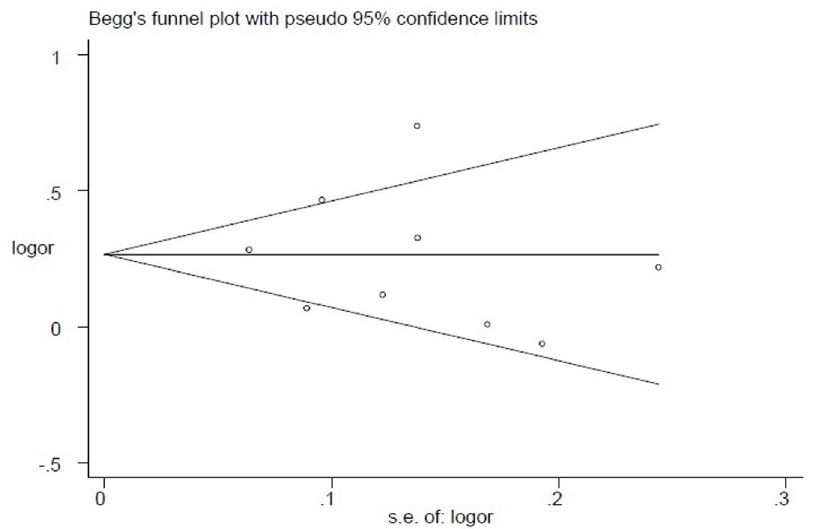
Figure 4. Begg’s funnel plot of selected studies. Asymmetry of the plot indicates publication bias. The horizontal line represents the meta- analysis summary estimate, the diagonal lines pseudo-95% CI limits about the effect estimate. logor, natural logarithm of the OR; s.e. of logor, standard error of logor.